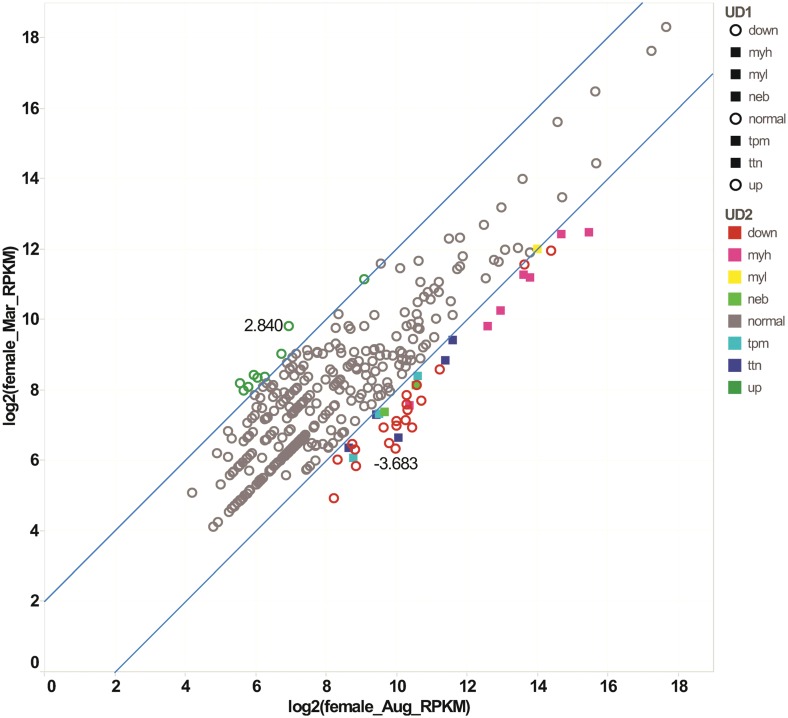
Differentially expressed genes (DEGs) in fast skeletal muscle of female Atlantic cod between August and March.DEGs were determined by pairwise comparison when their log2 fold change was log2 Ratio > 2 (upregulated gene) or log2 Ratio < -2 (downregulated gene). X- and y-axis indicate the log2 (RPKM values of female muscle in August) and log2 (RPKM values of female muscle in March), respectively. Green circles represent upregulated DEGs and red circles indicate downregulated DEGs. Grey circles show the UniGenes that did not display significant changes.